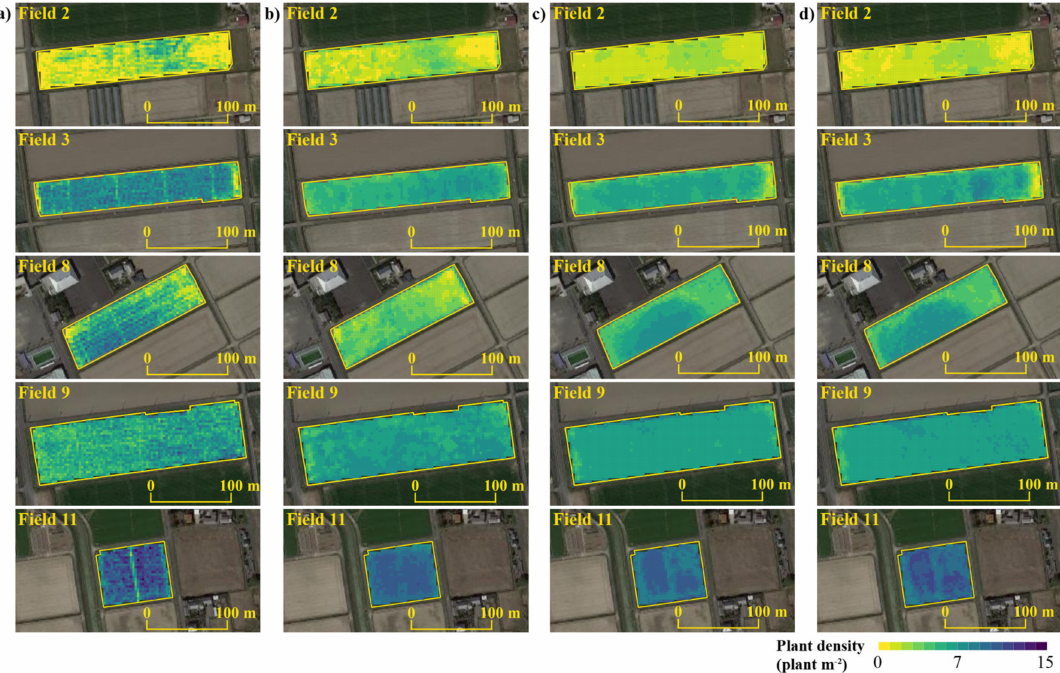
Figure 10. Spatial distribution of plant density in test fields as the result of the ( a ) YOLOv3 best model; ( b ) SR + NDVI-PLS; ( c ) NDVI + Climate-RF; ( d ) 10VarImp-RF. The resolution of the distribution maps was 3 × 3 m per pixel to match the spatial resolution of the PlanetScope